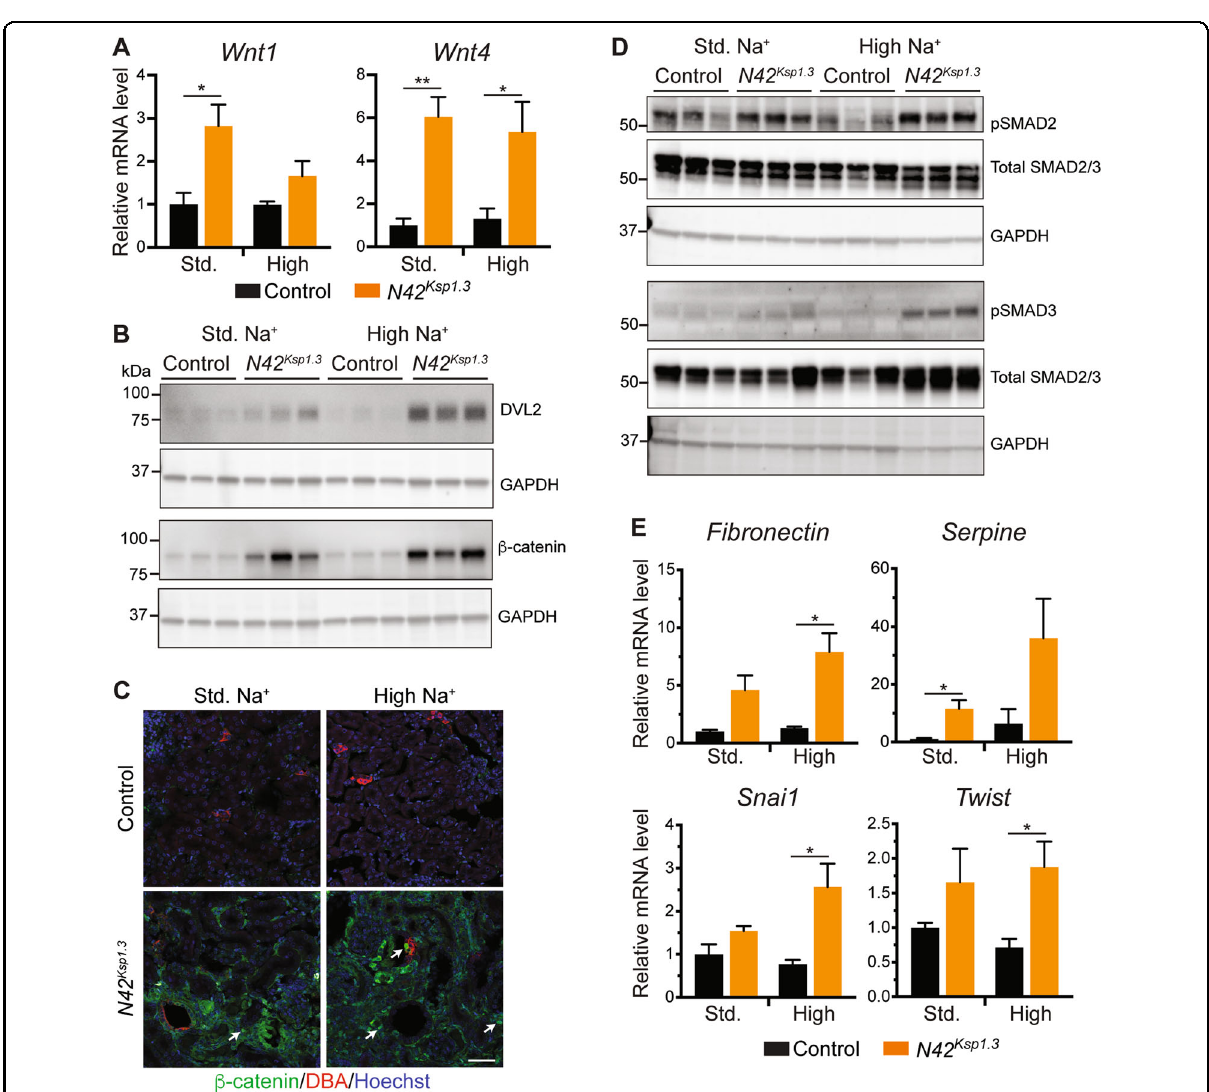
Fig. 4 Damage to parenchyma involves sustained activation of Wnt/ β -catenin and TGF- β signaling. A qRT-PCR analysis of Wnt1 and Wnt4 genes relative to the TBP housekeeping gene. B Immunoblot analysis of β -catenin and DVL2 with GAPDH as a loading control. C Immunostaining of β -catenin (green) with DBA marker for collecting ducts (red). DNA is stained by Hoechst (blue). Arrows indicate nuclear staining. Scale bar: 50 μ m. D Immunoblot analysis of pSMAD2/3 and total SMAD2/3 with GAPDH as a loading control. E qRT-PCR analysis of genes relative to TBP . Data presented as means ± SEM and signi fi cance determined using unpaired two-tailed Student ’ s t test, n = 3 – 4. * P < 0.05, ** P <